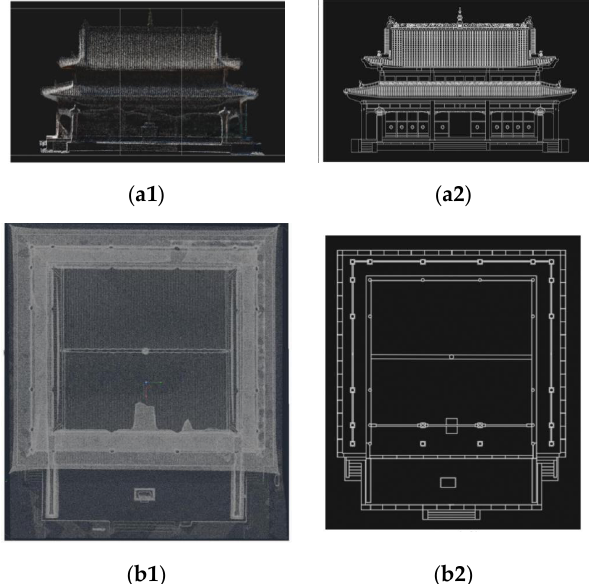
Figure 6 . The extraction results of the point cloud information: (a1) Facade of the point cloud of Baoguang hall; (a2) extracted facade line drawing from the point cloud; (b1) plan of the